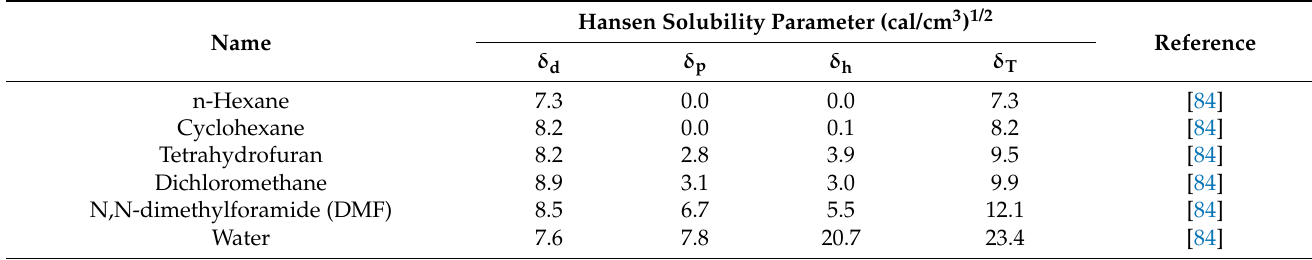
Table 2. Hansen solubility parameters (HSPs) of solvents and polymers used in the design of Ln 3+ -containing nanomaterials [28,73,83,87] and of blood components [85]. The data are adapted from references [60,62,63,84,85] with